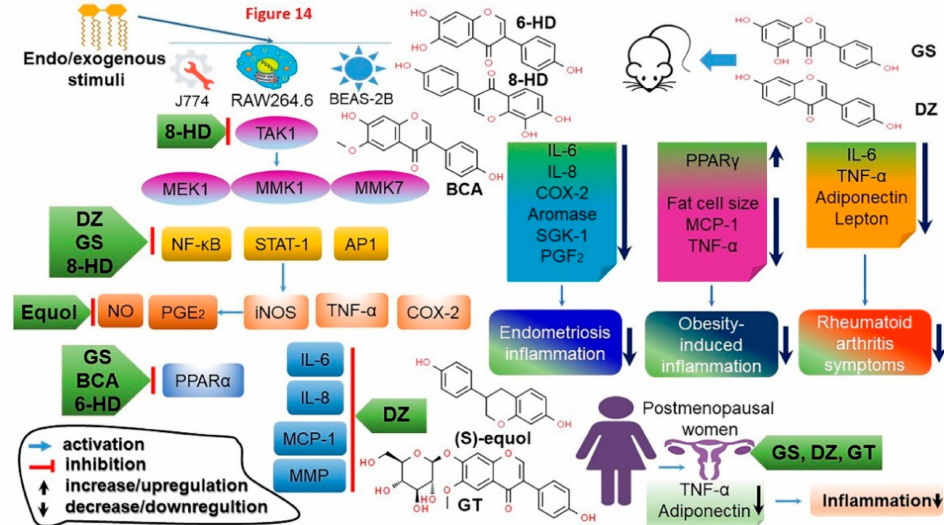
Figure 8. Inhibition of lipopolysaccharide (LPS)-induced inflammation in J774, RAW 264.7, and BEAS- 2B cells by isoflavones [genistein (GS) and daidzein (DZ)] and their metabolites [6-hydroxydaidzein (6-HD), 8-hydroxydaidzein (8-HD), glycitein (GT), biochanin A (BCA), and S -equol]. 8-HD inhibits the expression of mitogen-activated protein kinase kinase (MEK1) and mitogen-activated protein kinase homologs MMK1 and MMK7 following inhibition of transforming growth factor β -activated kinase (TAK1). DZ, GS, and 8-HD inhibit the expression of the nuclear factor kappa B (NF- κ B), signal transducer and activator of transcription 1 (STAT1), and activator protein 1 (AP1). S -equol blocks nitric oxide (NO) and prostaglandin E2 (PGE 2 ) production. GS, BCA, and 6-HD inhibit the expression of the peroxisome proliferator-activated receptor-alpha (PPAR α ). Finally, DZ represses interleukin (IL)-6 and -8, monocyte chemoattractant protein-1 (MCP1), and matrix metalloproteinase (MMP) expression. In addition, GS and DZ reduce proinflammatory cytokines in different inflammatory manifestations in animal models, such as endometriosis, obesity, and rheumatoid arthritis models, via the regulation of multiple genes associated with inflammation. For postmenopausal women, aglycones (GS, DZ, and GT) reduce inflammation by downregulating tumor necrosis factor-alpha (TNF- α ) and adiponectin [78]. Figure adapted from Hsiao et al.